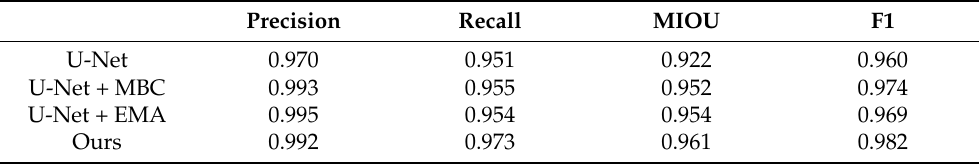
Table 2. Comparison of evaluated indicators of the combination of different modules.